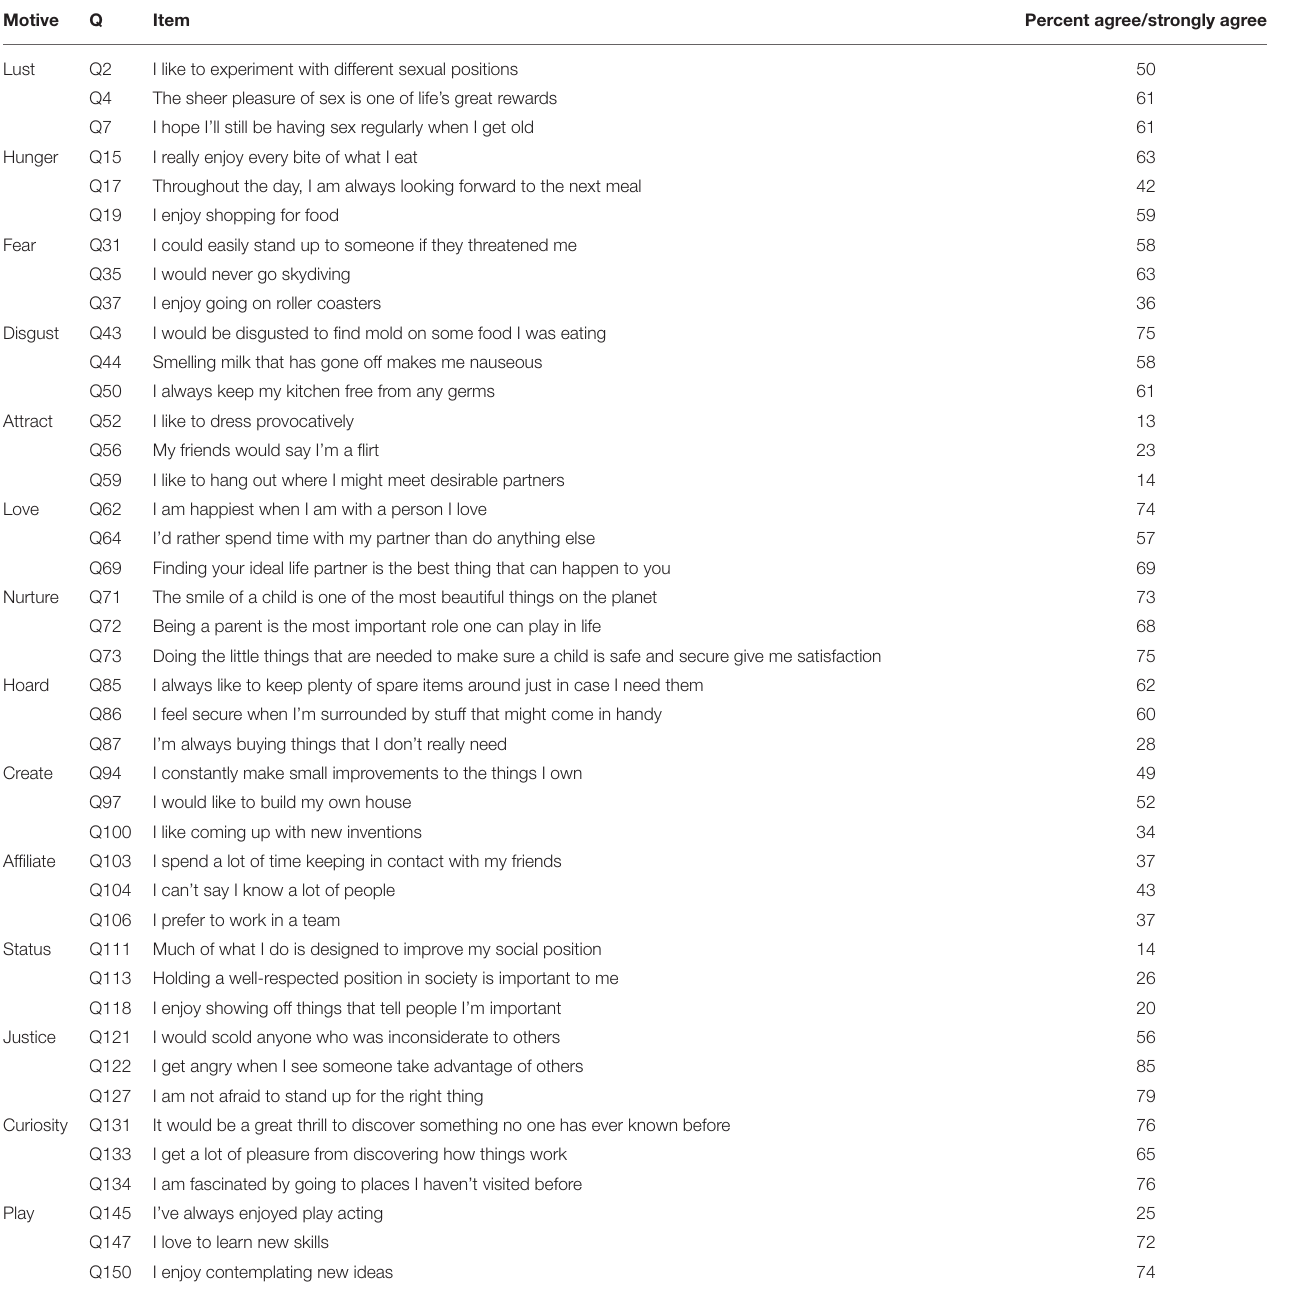
TABLE 6 | Reduced Human Motives